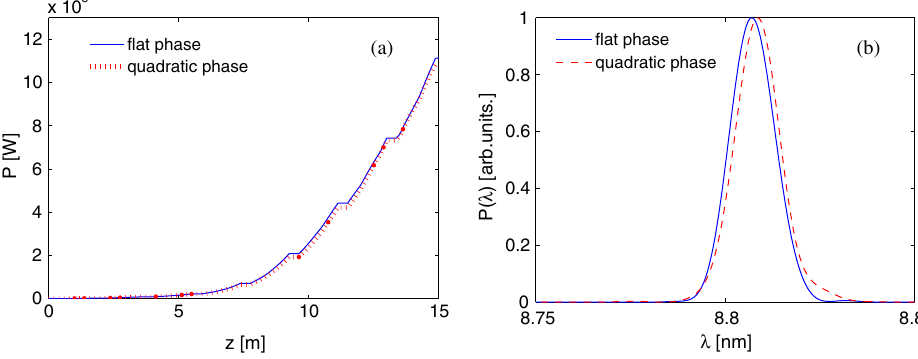
FIG. 14. 30th harmonic radiation performances of EEHG for the 16 fs seed laser pulses with flat phase (blue line) and quadratic phase (red dashed line): (a) FEL gain curves; (b) spectra at saturation.